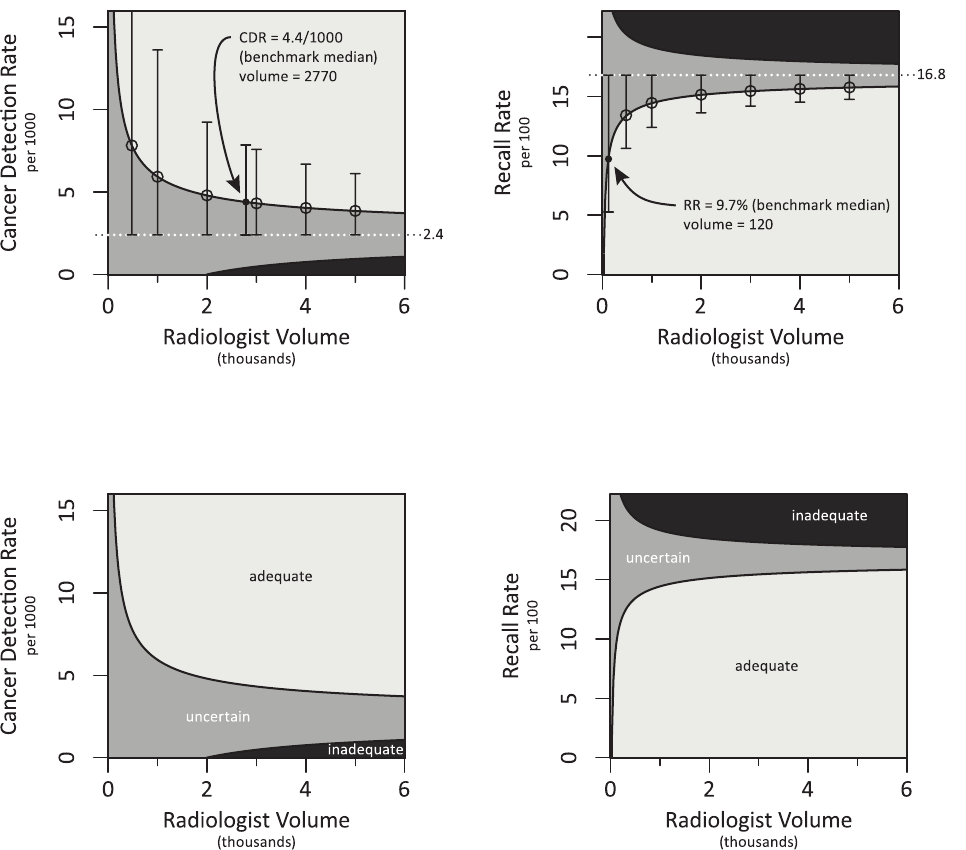
Figure 1. Defining adequate performance based on volume. Plots demonstrate our method for constructing curves by using the benchmark threshold as the limit of 95% confidence based on volume: (A) CDR performance levels are established using 2.4 as the lower boundary for 95% CI of adequate performance (CIs shown) and the upper boundary for inadequate performance (CIs not shown). This methodology shows (indicated with a black dot) that a volume of 2770 is required to confidently assert the CDR benchmark median of 4.4/1000 is adequate; (B) RR performance levels are established using 16.8 as the upper boundary for 95% CI of adequate (CI shown) and inadequate (CI not shown) performance. A volume of 120 (indicated with a black dot) is required to confidently assert the RR benchmark median of 9.7% is adequate. Plots define regions of adequate, uncertain, and inadequate performance for (B) CDR and (D) RR.